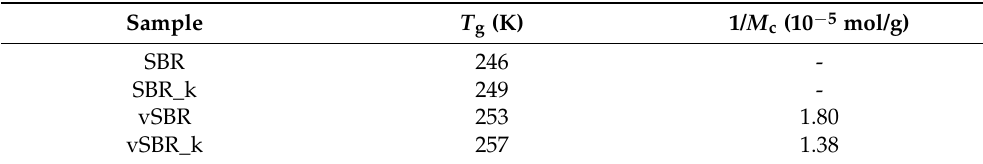
Table 2. T g values obtained by DSC experiments and crosslink density (1/ M c ) values determined by equilibrium swelling